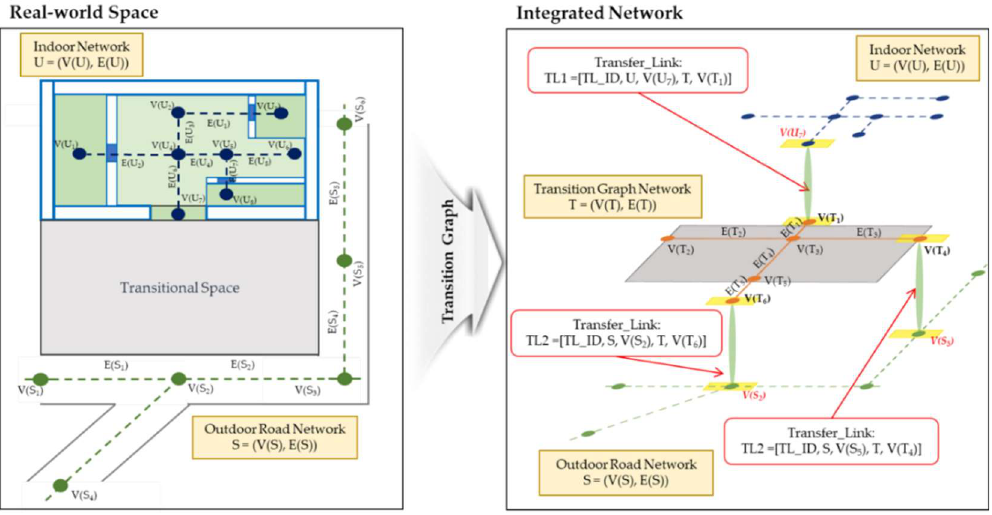
Figure 6. Generating the network representation for the Transitional